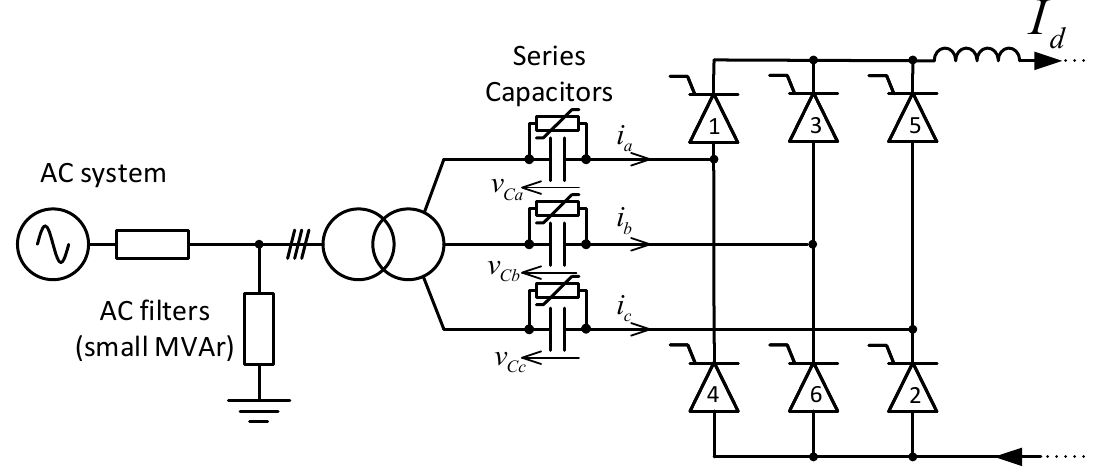
Figure 29. Capacitor Commutated Converter.